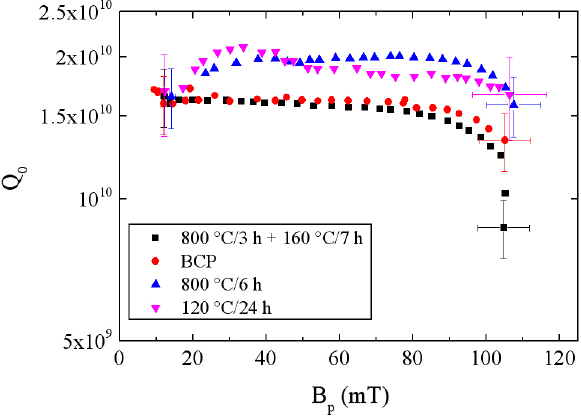
(cid:1) C , ð 2 : 0 K Þ vs B FIG. 6. Q p measured after etching by BCP, 0 followed by HT at 1200 (cid:1) C and by